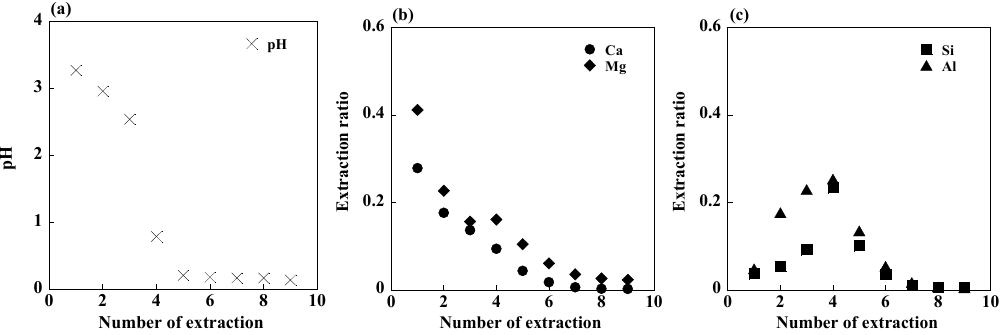
Figure 2. ( a ) Leachant pH and the step-wise extraction ratio of ( b ) Ca, Mg, ( c ) Si and Al into 1 M HCl solutions as a function of the number of leaching treatments.